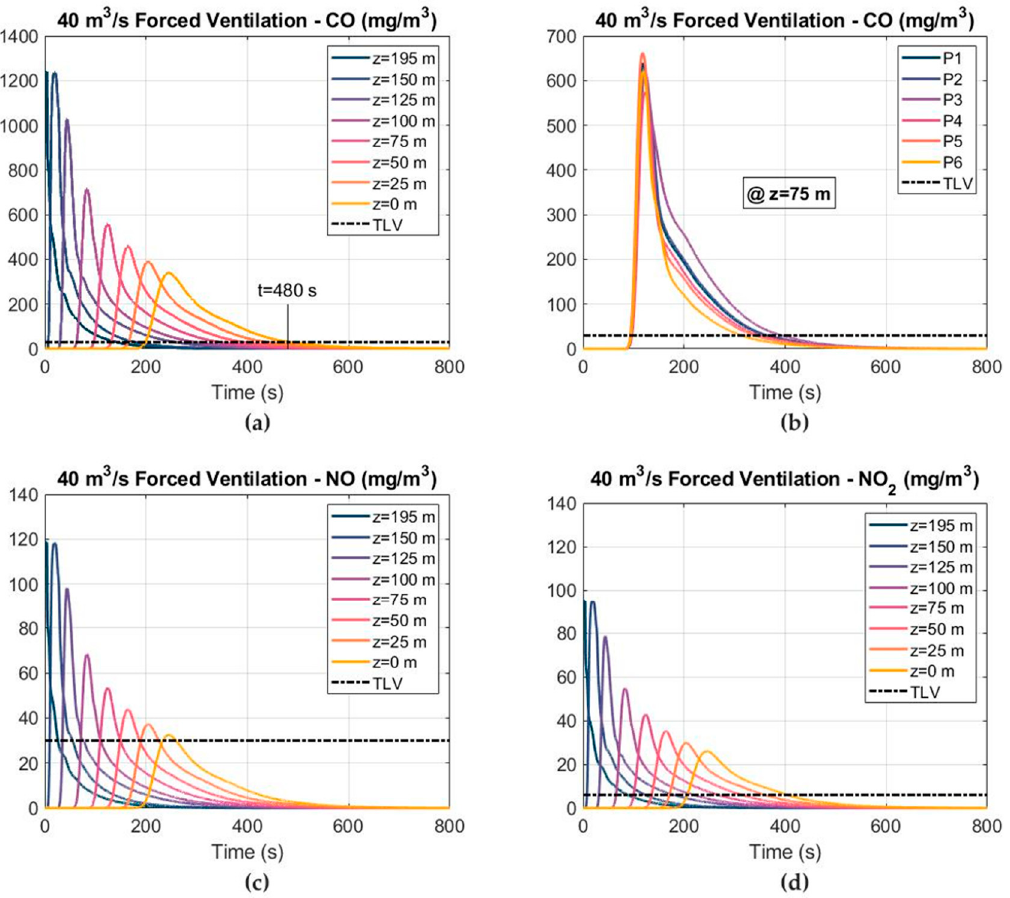
Figure 13. Distribution of the toxic gas mass concentrations and TLVs at different cross sections, considering an airflow of 40 m 3 s − 1 and forced ventilation: ( a ) CO mass concentration; ( b ) CO mass concentration at different points in the cross section of Z = 75 m; ( c ) NO mass concentration; and ( d ) NO 2 mass concentration.